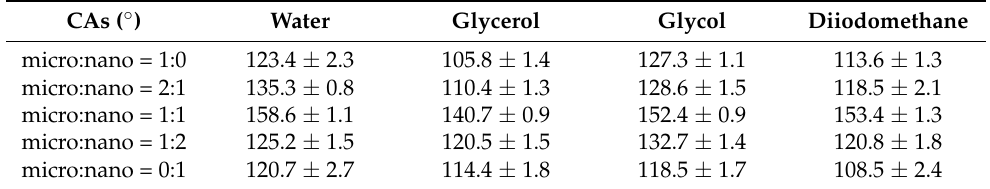
Table 2. CAs for different liquids of fluorinated epoxy coatings with different proportions of micro/nano-silica.